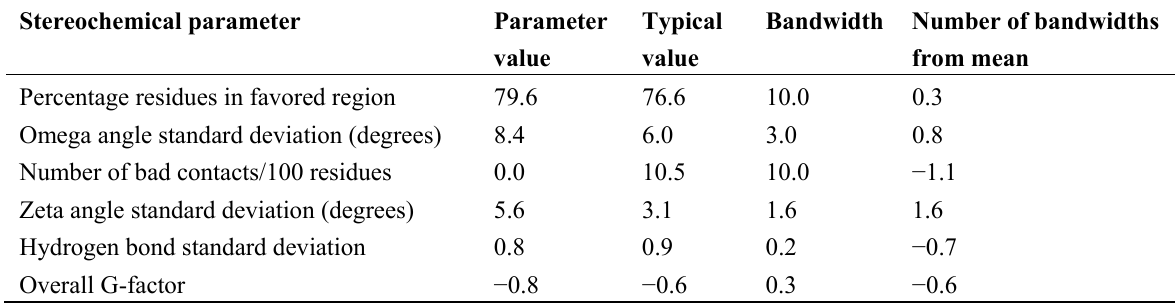
Table 2. Comparison of the stereochemical properties of DehD to typical